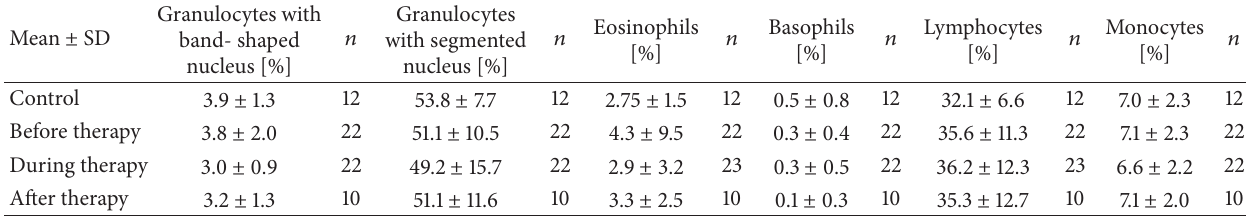
Table 3: Peripheral blood smear before, during, and/or after EPT.